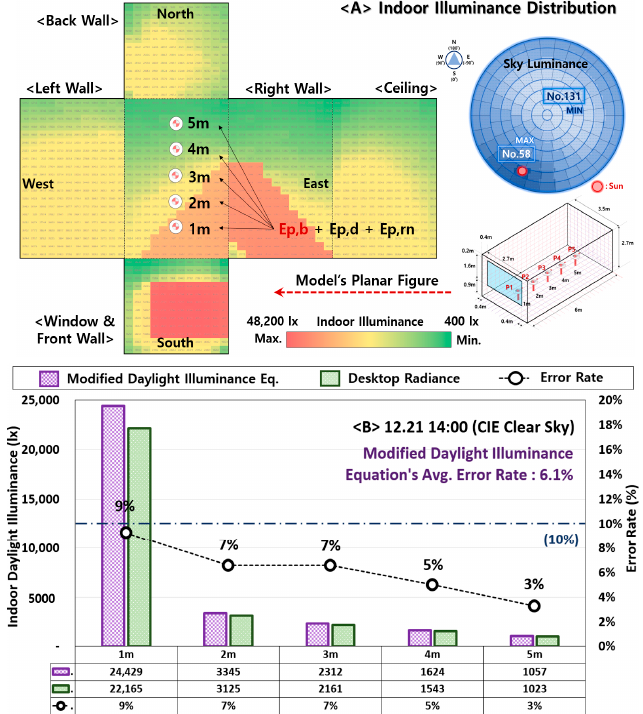
Figure 17. Indoor illuminance distribution of the six–side planar figure and comparison of illuminance between the modified equation and Desktop Radiance (CIE Clear Sky_12.21 14:00).